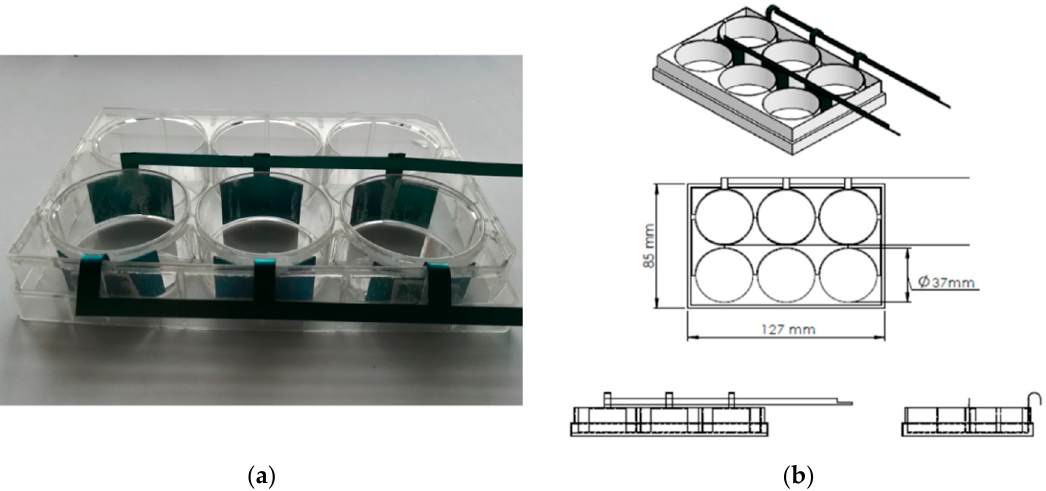
Figure 1. Experimental test setup. ( a ) The processed 6 well tissue culture plate with titanium electrodes. ( b ) Technical drawing of the system for capacitively coupled electric field stimulation.